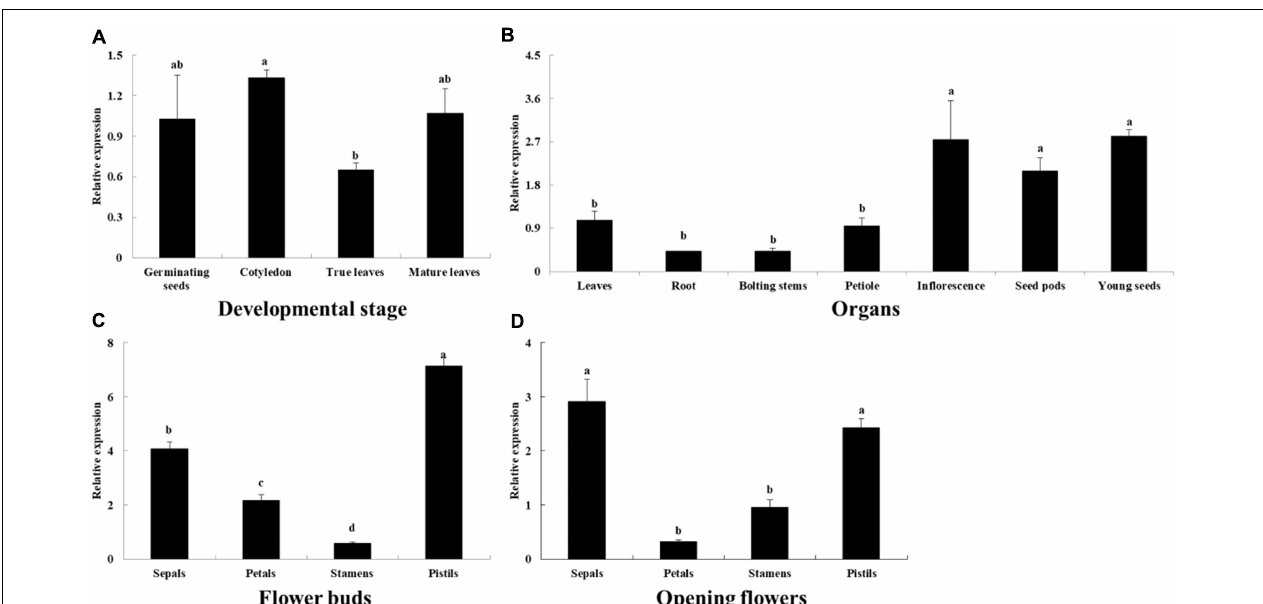
FIGURE 2 | Expression levels of BoaCRTISO in different developmental stages: (A) organs, (B) flower organs in flower buds stage (C) , and opening flowers stage (D) of Chinese kale. The BoaCRTISO expression of germinating seeds was set as 1. The samples were a mixture from three individual plants. Data are expressed as mean ± standard deviation. The same letter in the same histogram indicates that there is no significant difference between the values tested by least significant difference (LSD) ( p <